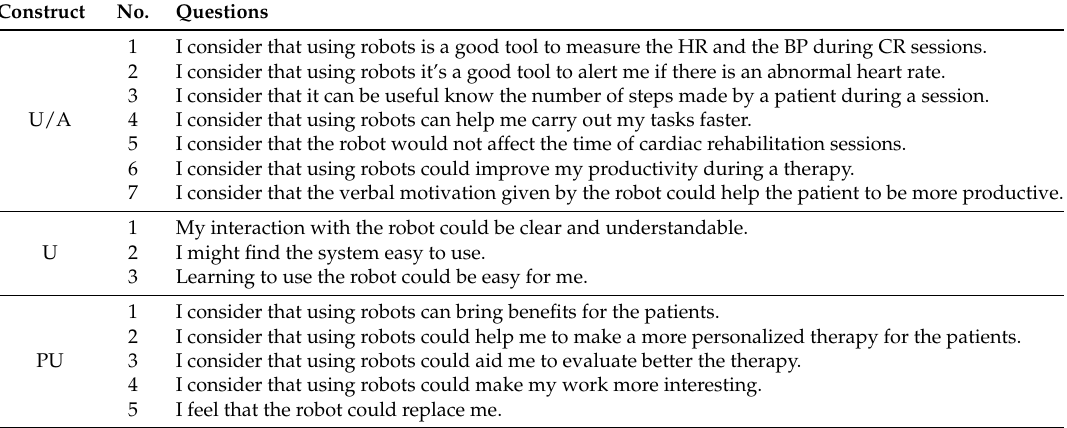
Table A2. Acceptance Questionnaire for